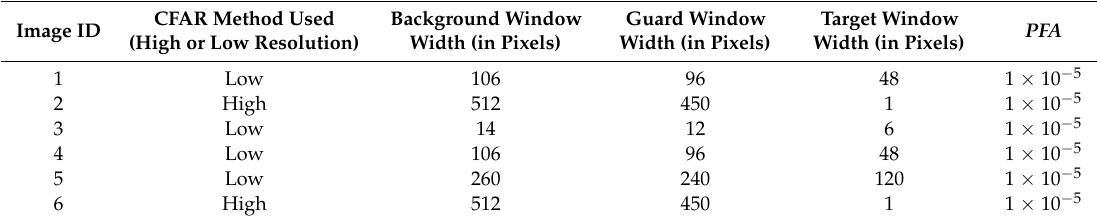
Table 3. Parameters for each experiment. PFA is the probability of false alarm.